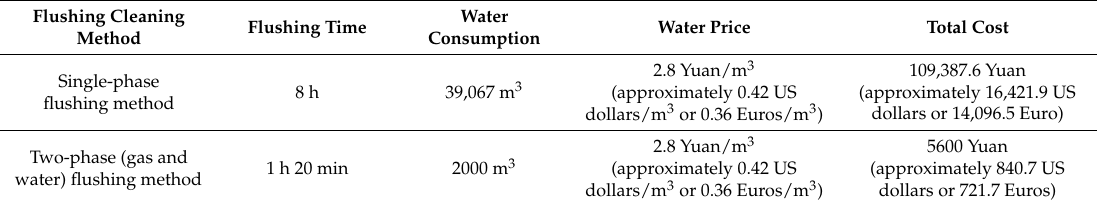
Table 17. The comparison of two flushing methods in this case